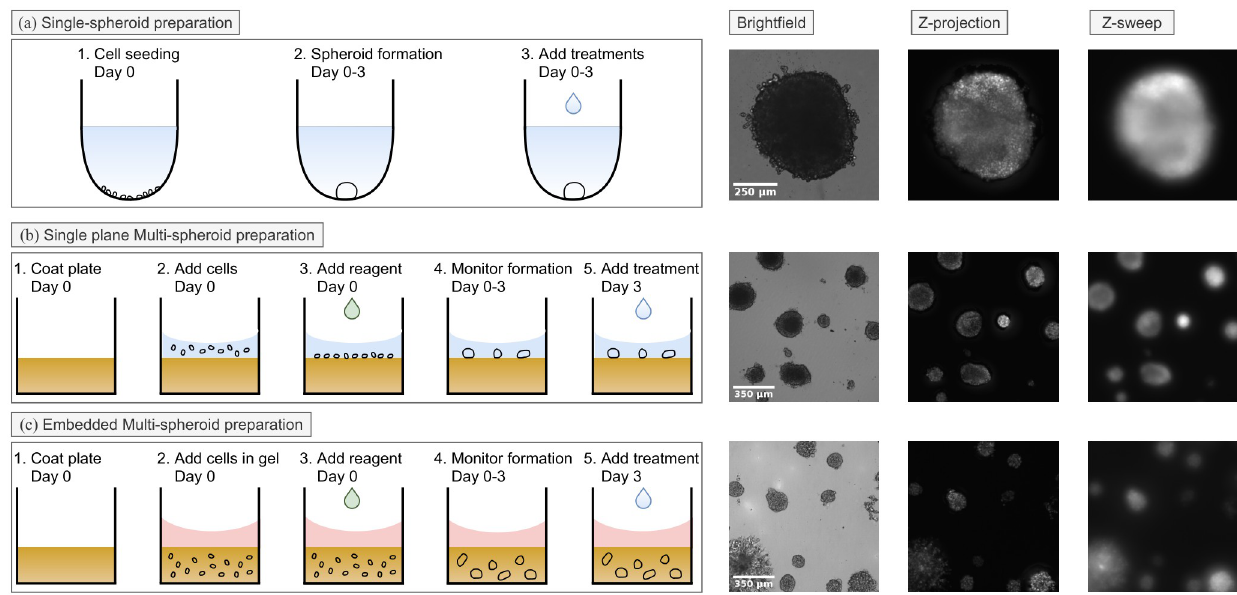
Fig 4. Graphical summary of establishment and image acquisition of 3D tumour spheroid datasets. (a) In a single spheroid assay, cells were seeded into a ultra-low attachment round bottom 96-well plate and allowed to form a single spheroid. (b) In a single plane multi spheroid assay format, cells were seeded into a polymerized bed of 1 , where they grow into multiple spheroids in what is effectively a single optical plane. (c) In an embedded multispheroid assay, cells are resuspended in Matrigel 1 before placing in a flat bottom 96-well plate. Examples of brightfield, z-projection and z-sweep fluorescence images acquired 10 days post seeding are